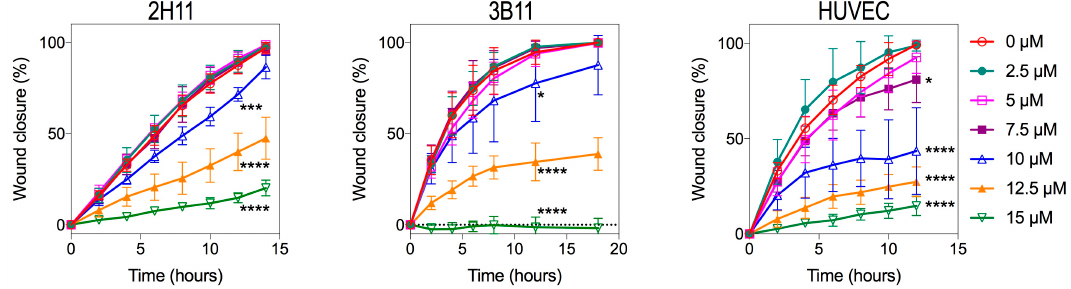
Figure 5. Endothelial cell migration was inhibited by bacopaside II. Wound area for 2H11, 3B11 and HUVEC was measured using NIS-Elements software (Nikon, Tokyo, Japan) and the percentage closure calculated relative to that at Time 0 for each cell line. Data are the mean ± SD of six replicates from a representative experiment. p -values are for closure relative to vehicle at 12 h, determined by one-way ANOVA with the Bonferroni test (* p < 0.05); *** p ≤ 0.0002; **** p < 0.0001).